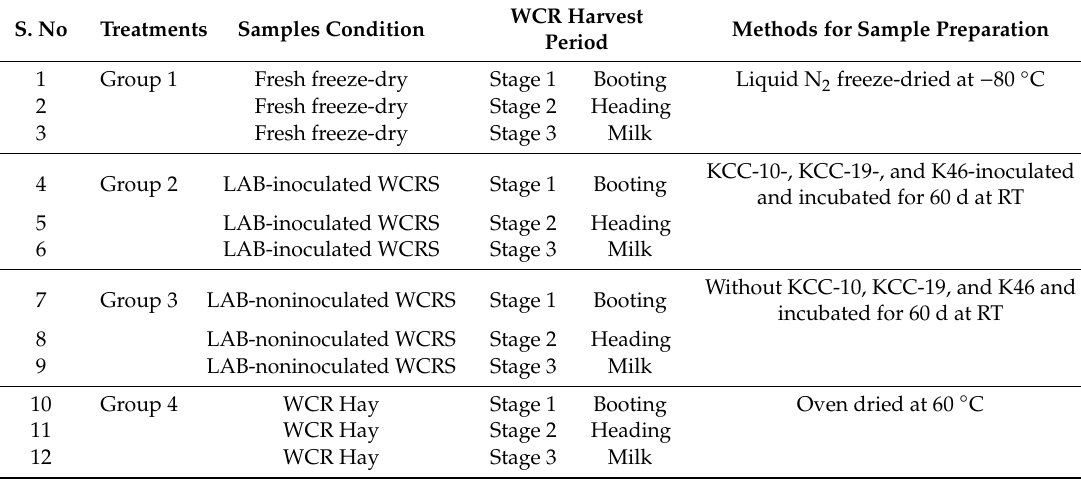
Table 1. Whole crop rice (WCR) samples and the di ff erent experimental set-ups used in this